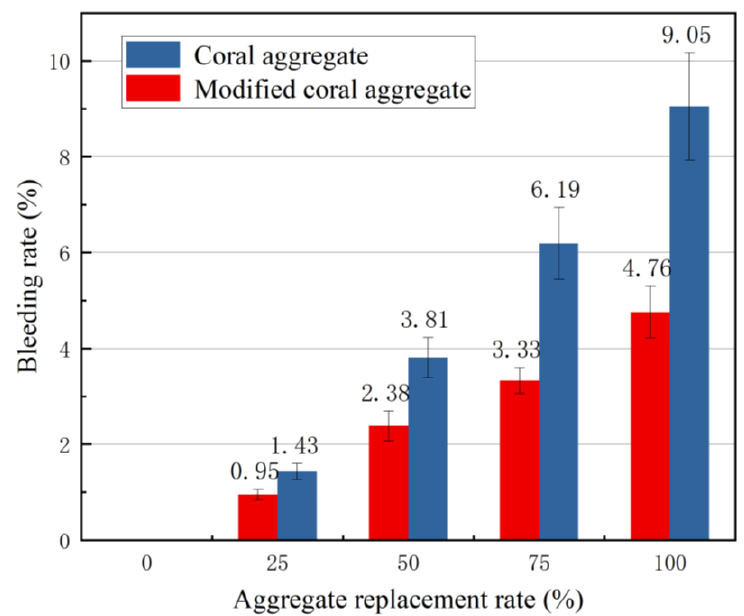
Figure 12. Relationship between aggregate replacement rate and bleeding rate.